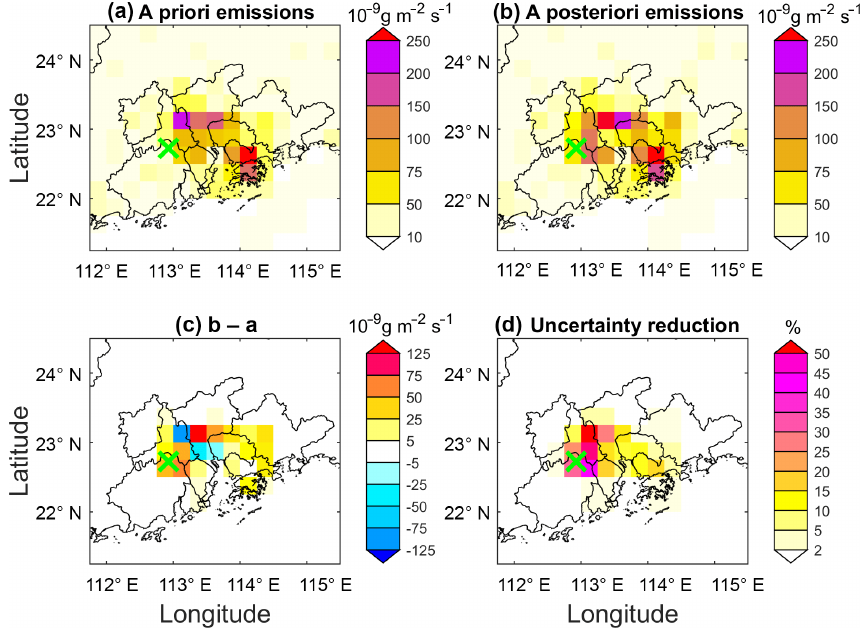
Figure 4. Maps of (a) a priori benzene emissions, (b) a posteriori benzene emissions, (c) differences between (b) and (a) , and (d) uncertainty reduction. The Heshan observation site is marked with a green cross.